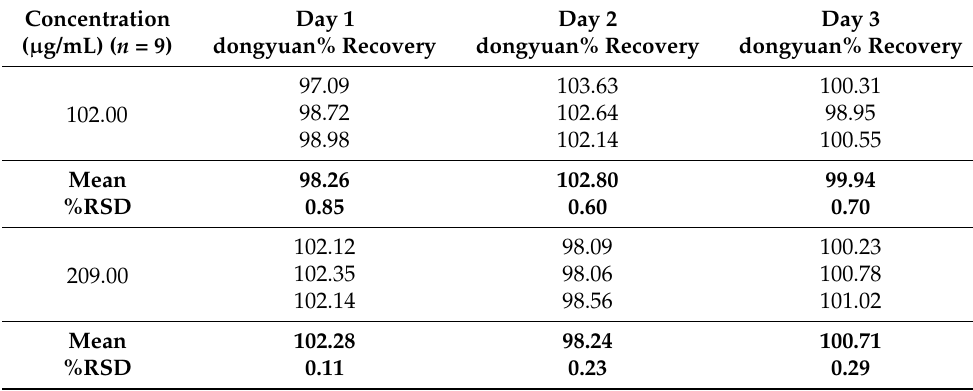
Table 4. Results obtained during inter-day precision testing of